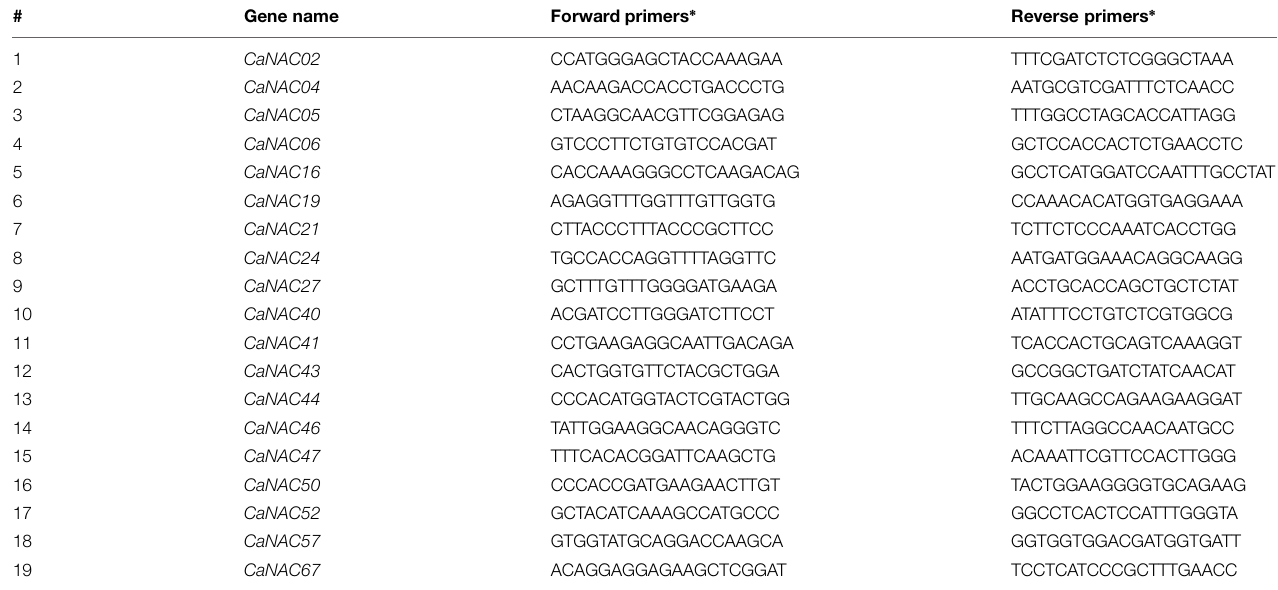
TABLE 1 | Primer pairs of 19 CaNAC genes used in RT-qPCR